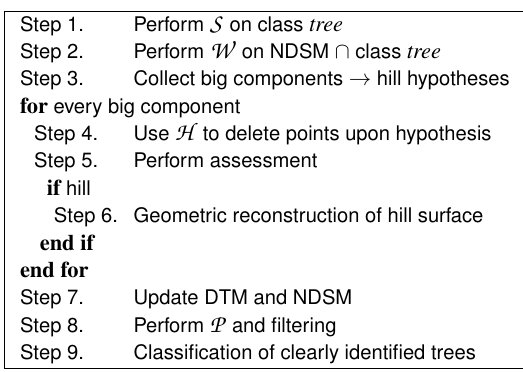
Algorithm 1. Overview of the proposed procedure. See text for